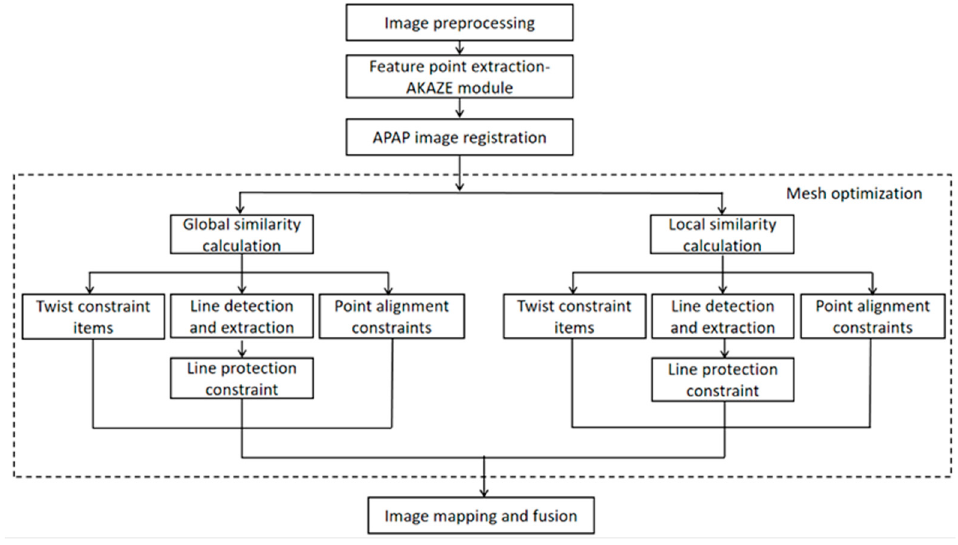
Figure 1. Flow chart of aerial image stitching.